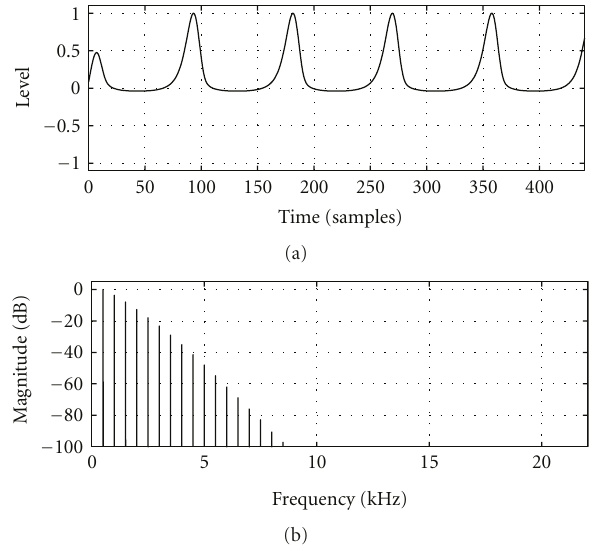
Figure 2: Peak-normalized FBAM waveform ( f 0 = 500Hz) and its spectrum. The sample rate f s = 44 . 1kHz is used in this and all other examples in this paper unless noted